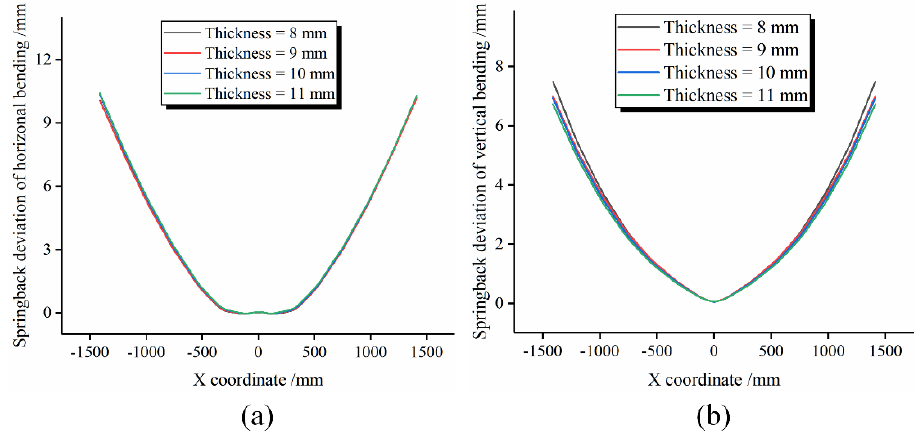
Figure 11. Springback deviation with different wall thickness of the profile. ( a ) Springback deviation of horizonal bending. ( b ) Springback deviation of vertical bending.